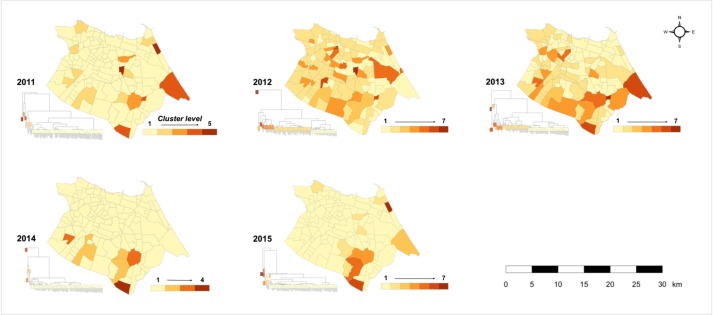
Hierarchical cluster maps of annual dengue transmission intensity in Fortaleza.Averages and ranges of parameter values by year and pattern are presented in S2 Table. Patterns were ordered low-high by annual case rates. Highest level patterns, particularly during lower-transmission years (patterns 6 and 7 in 2013 and 2015; pattern 4 in 2014), classify bairros with outlying case rates but shorter transmission intervals. Middle ranked patterns (patterns 2 and 3 in 2011; pattern 3 in 2012; pattern 5 in 2013 and 2015) were characterized by more populous bairros with longer intervals with continuous transmission, typically exceeding 40 weeks annually, and higher total case counts.